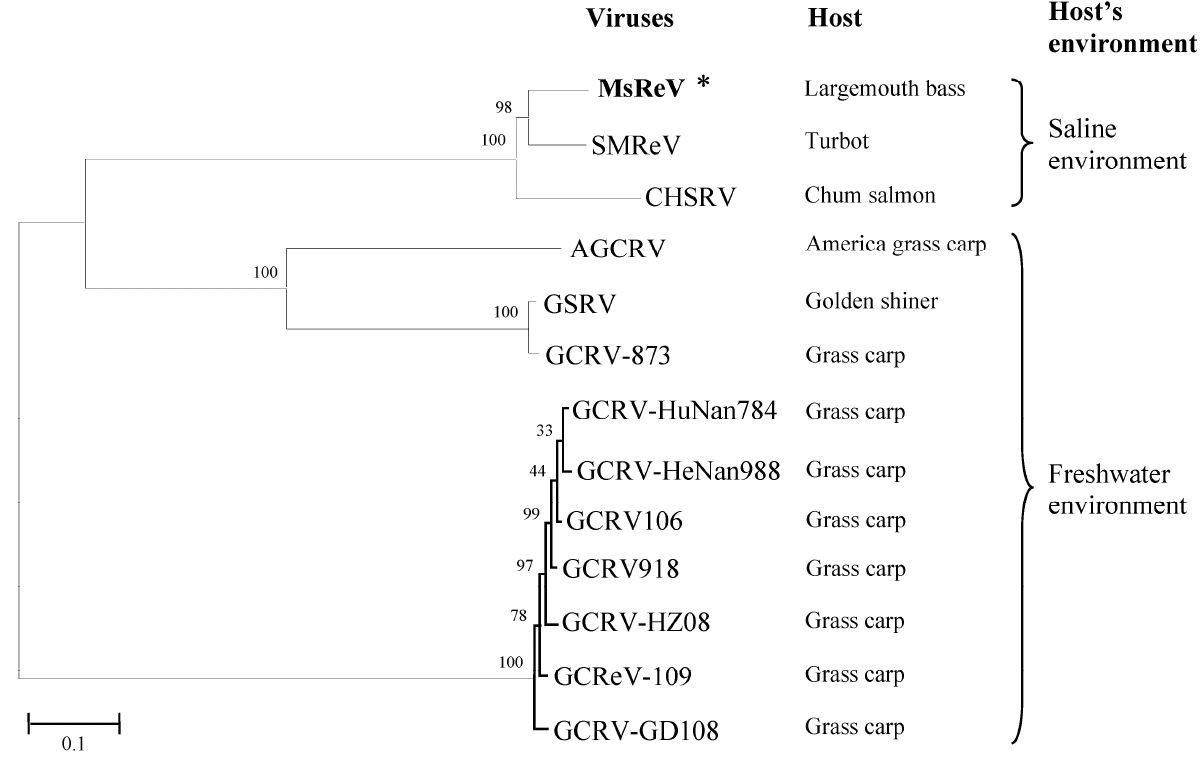
Figure 5. Phylogenetic tree of aquareoviruses based on concatenated sequences of seven structural proteins. Bootstrap values (%) for 1000 replications are shown at branch nodes. The scale bar indicates number of amino acid substitutions per site. Two subgroups,